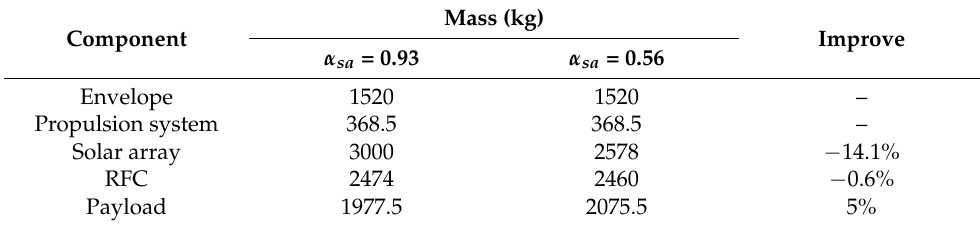
Table 5. Effect of solar array absorptivity on mass